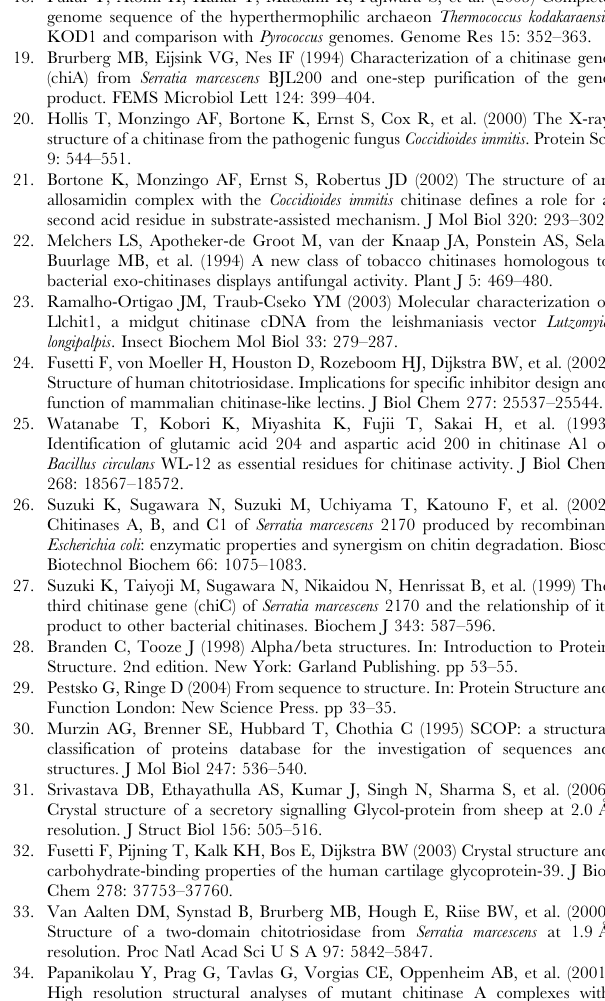
1UR9, 1KFW, and 1NWT) and the two conserved motifs on the CIDs. The structures were superimposed with the CE-MC method. (A) The eight structures 1HKM, 1LJY, 1ITX, 1D2K, 1FFR, 1UR9, 1KFW, and 1NWT are coloured in red, orange, yellow, green, blue, cyan, purple, and black, respectively. The aligned, blue, and cyan parts are TIM domain + CID, N-terminal domain on 1FFR, and C-terminal domain on 1UR9, respectively. (B) The two residues in the YxR motif are shown in red and orange, respectively; and the two residues in the [E/D]xx[V/I] motif are shown in yellow and blue, respectively. Figure S2 The larger multiple sequence alignment of sixty CID sequences from various species. The alignment was generated by MUSCLE in Jalview. It is not edited according to the three model structures. The two conserved motifs YxR and [E/D]xx[V/I] are highlighted in the red frames and the four conserved positions are labelled with red stars. The species names and GI numbers refer to Table S2. Table S1 List of twenty-one family 18 chitinases and chitinase- like proteins from plants, bacteria, fungi, and animals. Structures in bold are described and compared in the text.